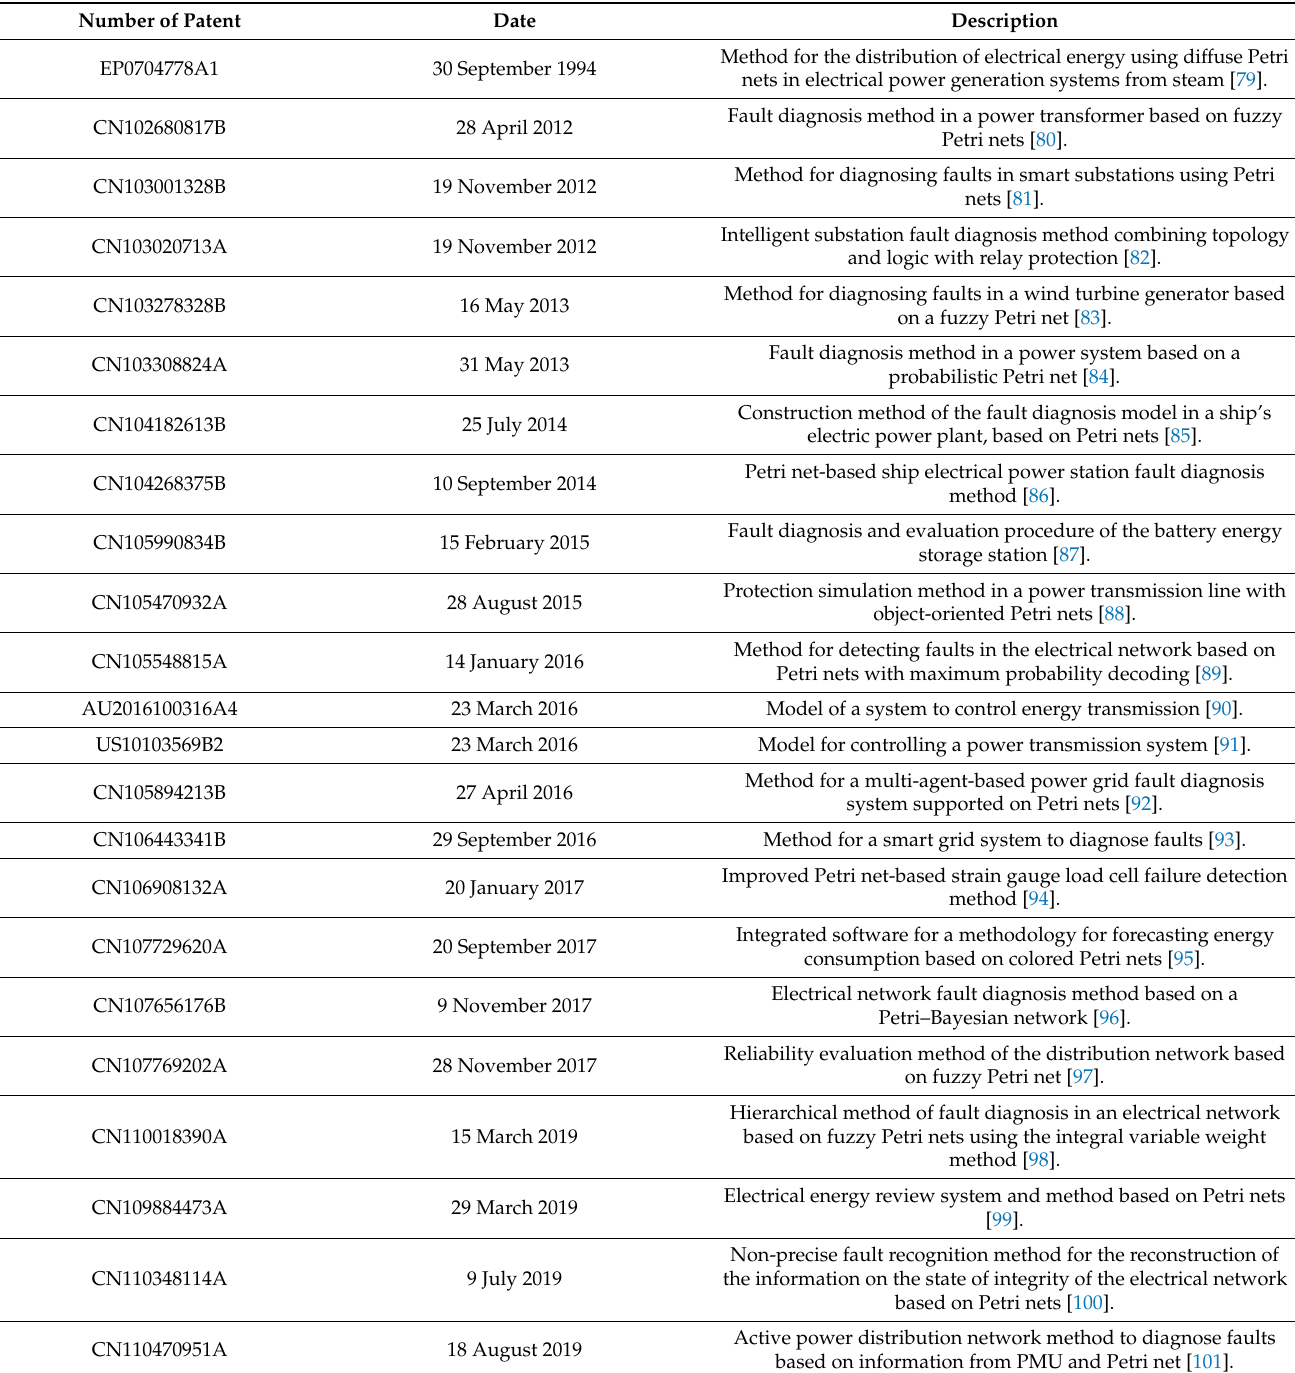
Table 2. Patents related to Petri